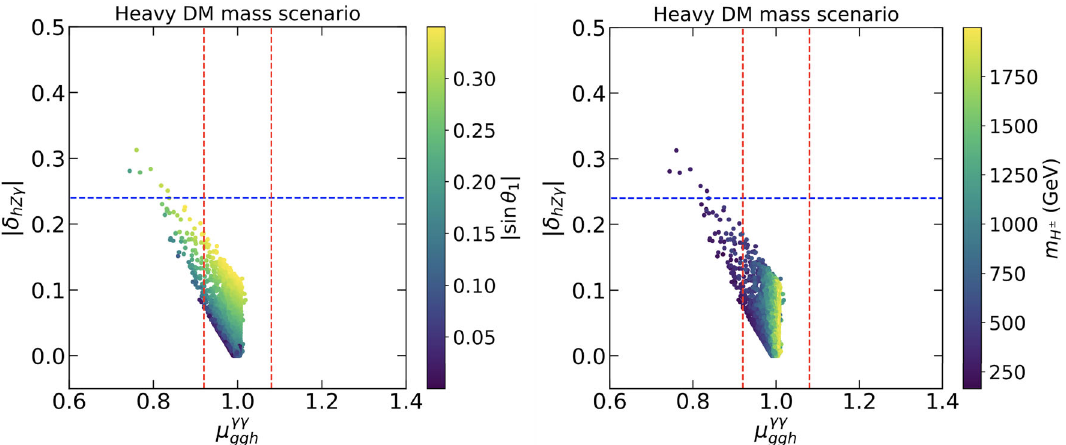
Fig. 16 The favored data points from CDF-2022+DM for the heavy DMmassscenarioprojectedonthe( μ ggh γγ , | δ hZ γ | )plane.Intheleftpanel the color gradient represents the mixing angle | sin θ 1 | while on the right panel it represents the charged Higgs mass m H ± . The region between